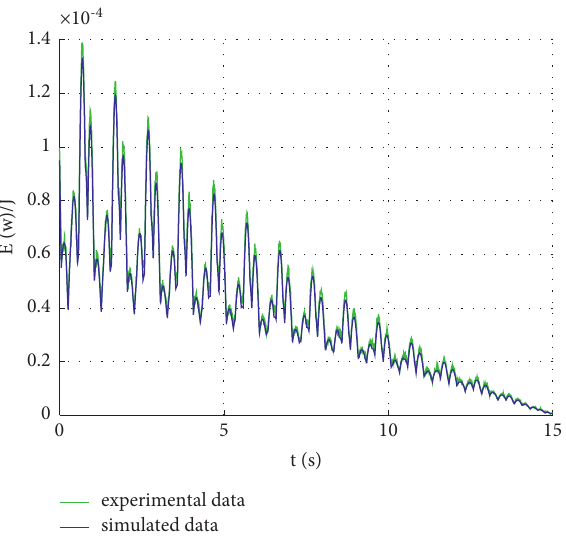
Figure 8: Comparison of the simulation and experiment for the energy consumption of the 3-RRR